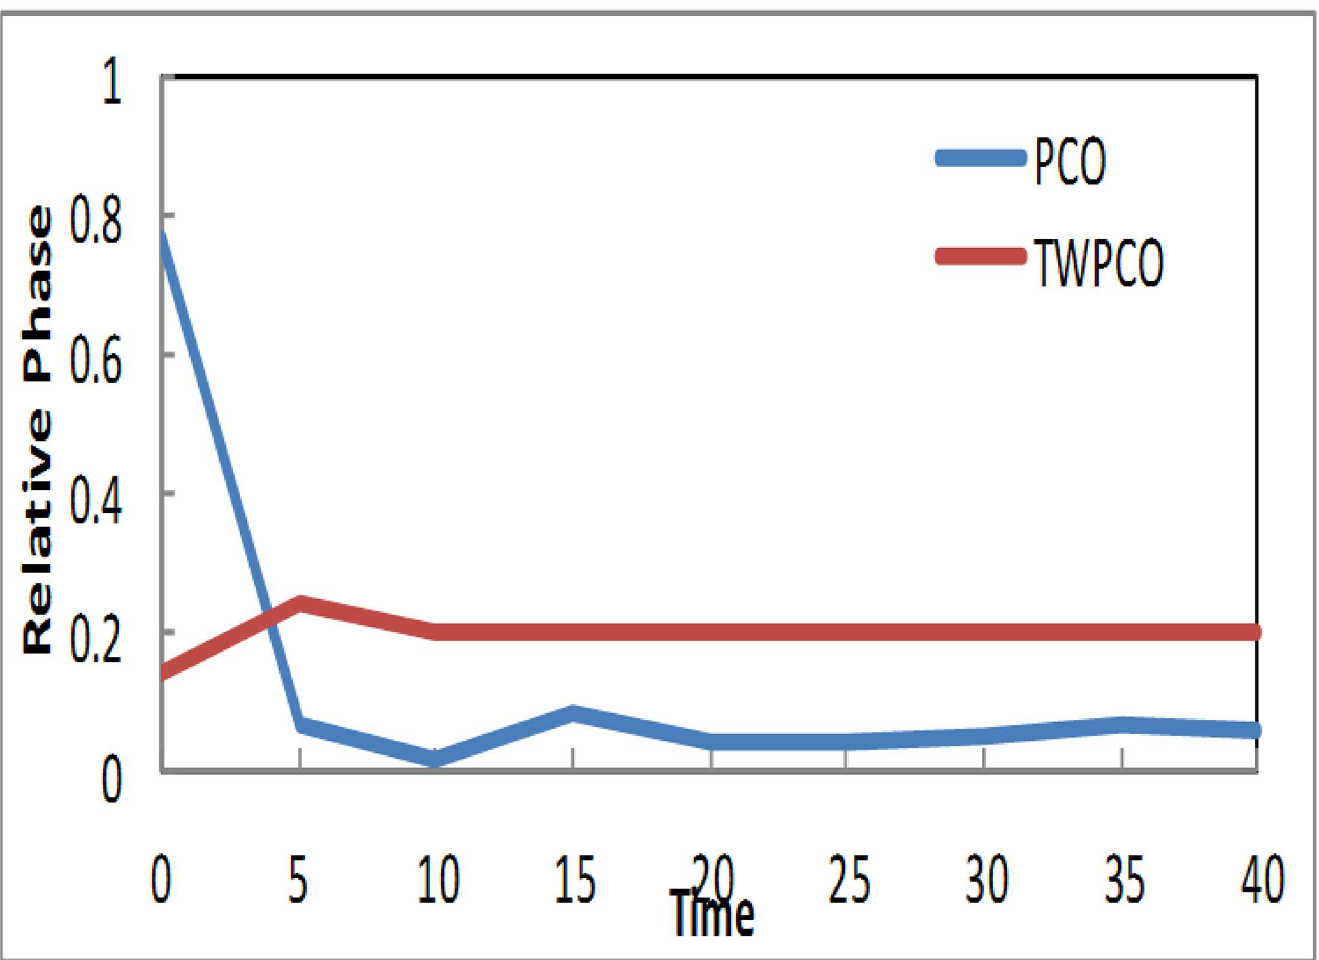
Fig 10. Relative Phase of Sensor TWPCO and PCO in regard to Node